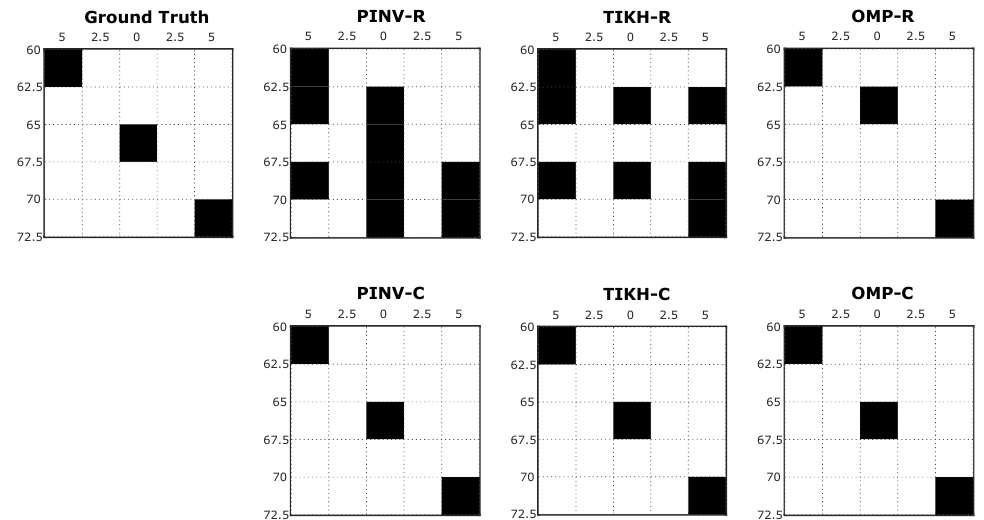
Figure 12. Examples of reconstructed images with three obstacles in the environment after